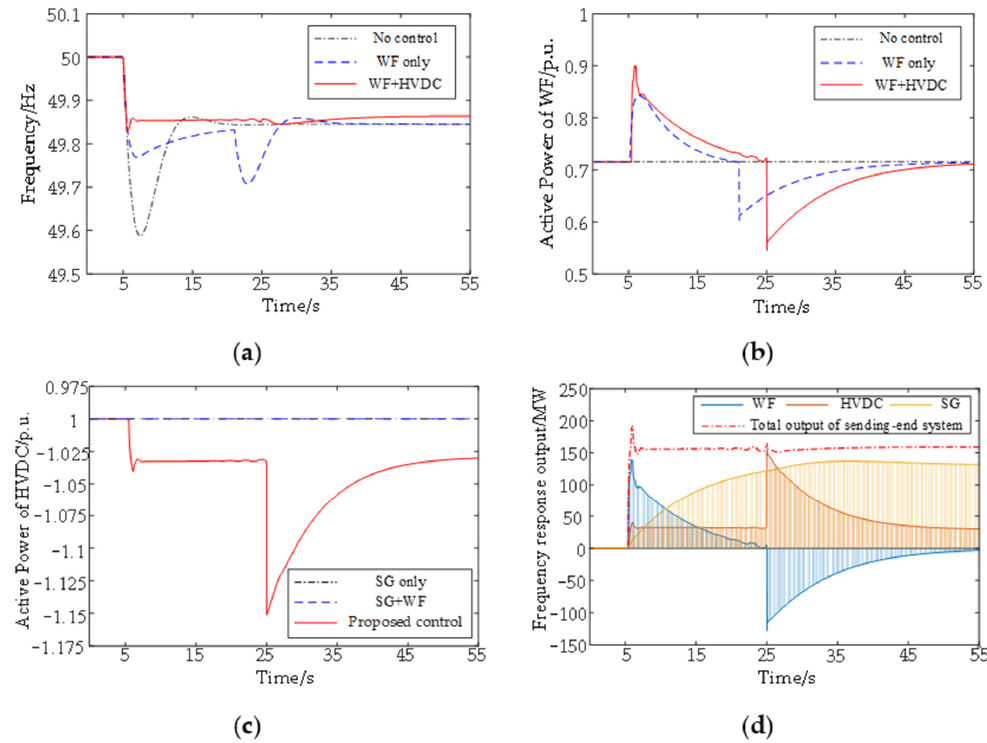
Figure 13. Simulation results under high wind power permeability and high wind speed condi- tion. ( a ) Sending-end system frequency, ( b ) active power of WF, and ( c ) active power of HVDC, ( d ) frequency response output of sending-end system. Table 5. Simulation results under high wind power permeability and high wind speed conditions.